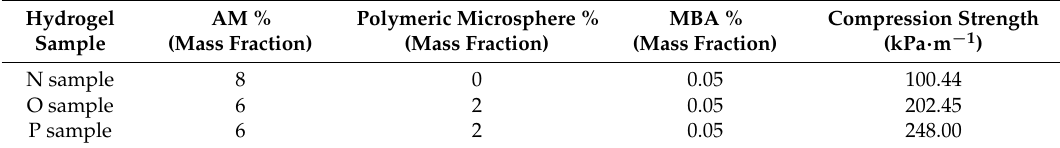
Table 1. Compression strength of hydrogels with different types of polymer